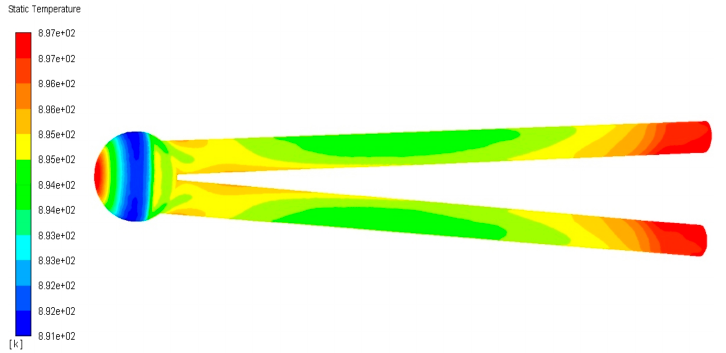
Figure 6. Static temperature distribution of thermocouple solder ball and wires.